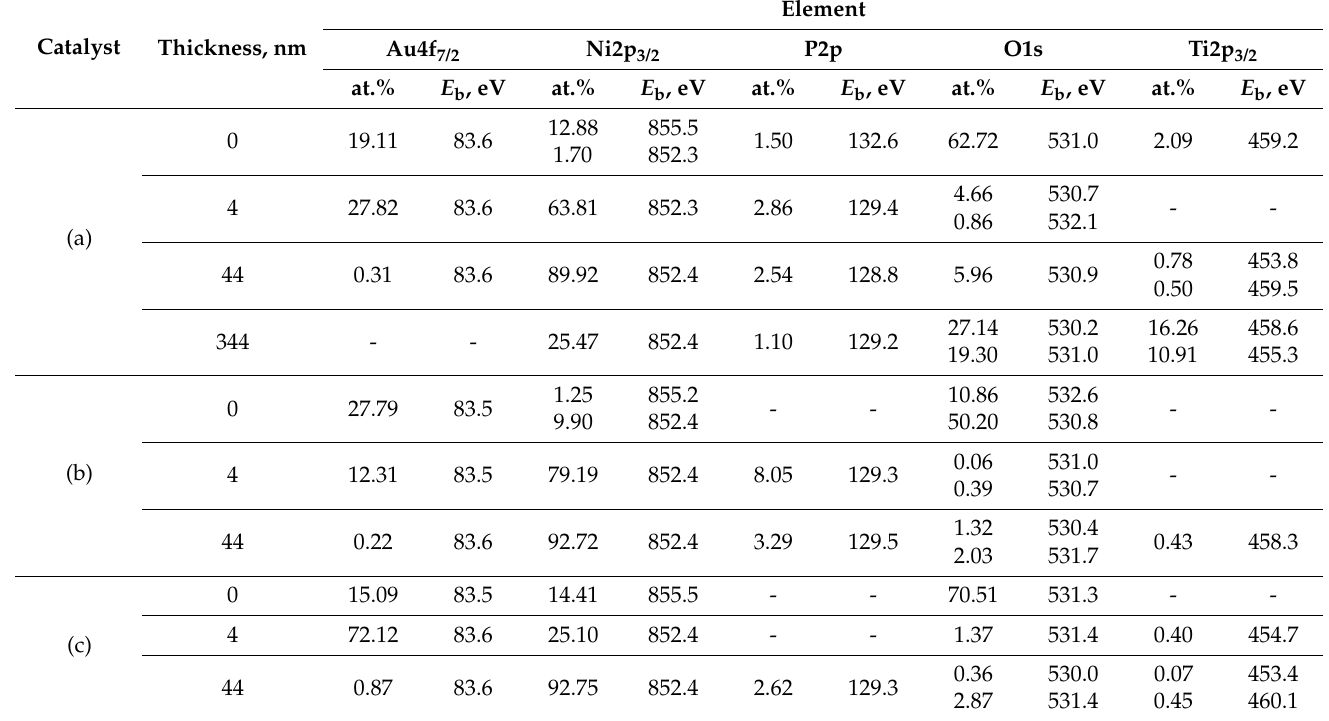
Table 4. The surface composition of AuNi-TiO 2 ntb catalysts determined by XPS analysis. The